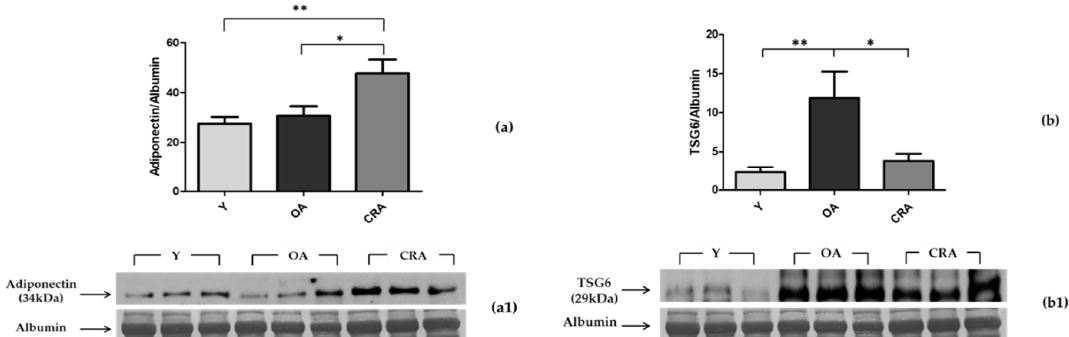
Figure 2. Western blotting of adiponectin ( a ) and TSG6 ( b ) in plasma samples of Y, OA, and CRA rats; ( a1 , b1 ) show the densitometric quantification of the blots. Protein loading was verified by plasmatic albumin level. Data are means ± SE of five determinations for each animal ( n = 6). Statistical di ff erences were evaluated by one-way ANOVA, followed by Bonferroni’s multiple comparison test (* p < 0.05; ** p <